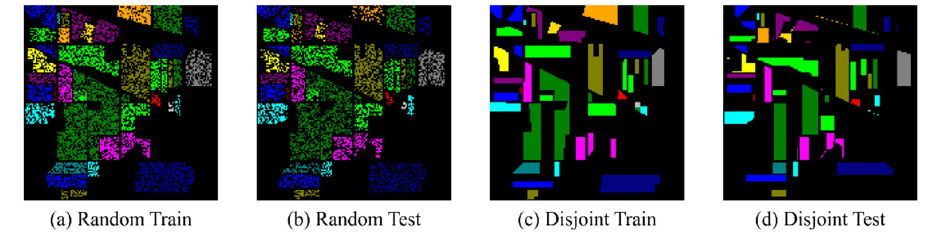
Figure 9. IP data set: sample distribution under random selection ( a,b ) and spatial disjoint selec-